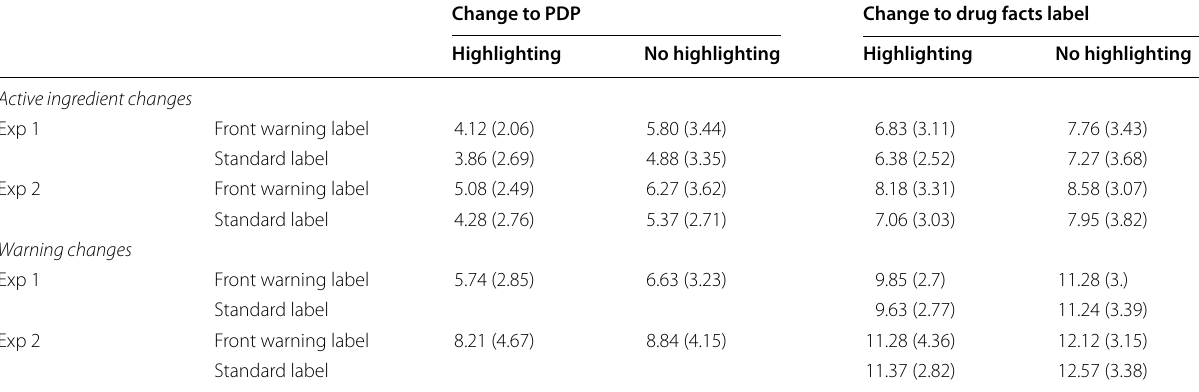
Table 1 Reaction times and standard deviations in seconds for all conditions in Experiments 1 and